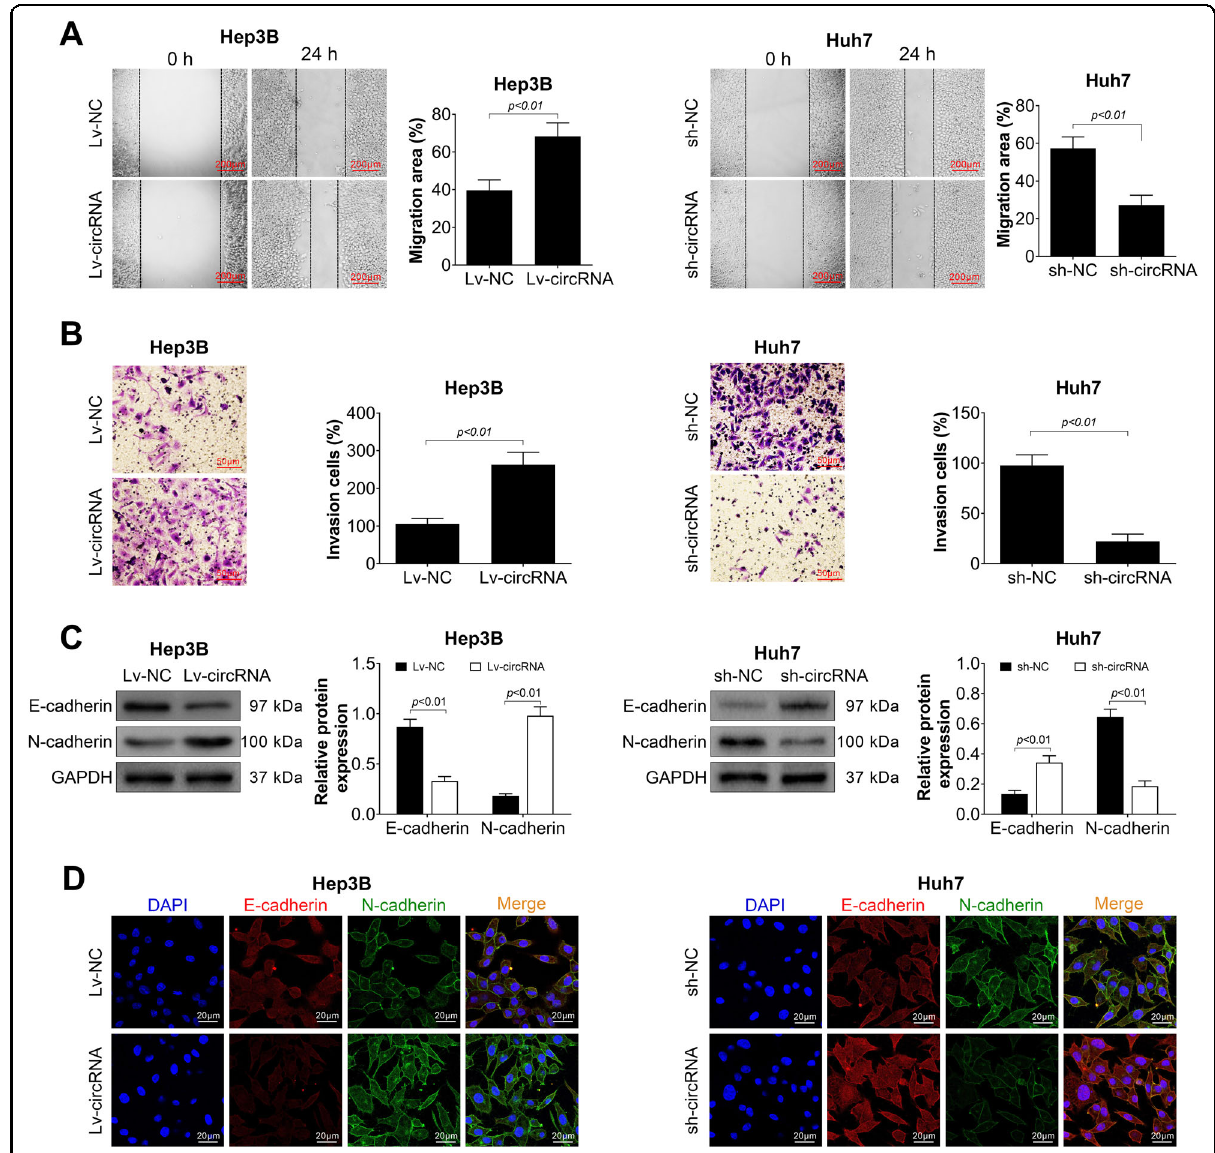
Fig. 3 Effect of has_circ_104348 on HCC cell migration and invasion. A and B The effect of has_circ_104348 on HCC cell migration and invasion was determined by wound healing assay ( A ) and transwell assay ( B ). The scale bars were 200 μ m. C and D The expression of E-cadherin and N- cadherin was tested by western blot ( C ) and IF ( D ). The scale bars were 20 μ m. Data were expressed as mean ±